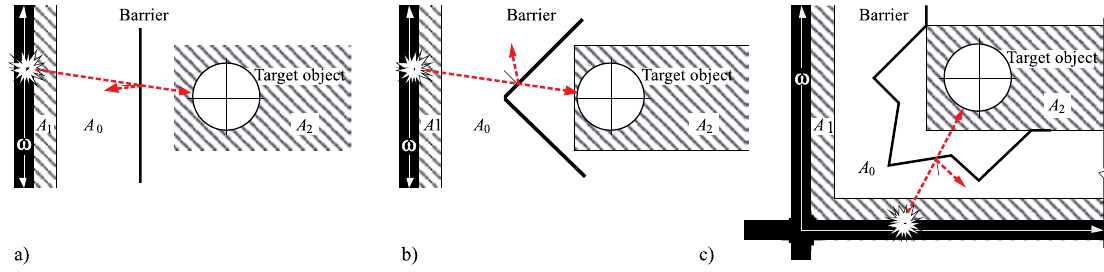
Fig. 4. Possibilities of a horizontal configuration of a barrier in the available area A 0 : a – straight single-segment barrier (“blast wall”); b – two-segment (“arrow headed”) barrier; c – multi-segment barrier (“arrow headed